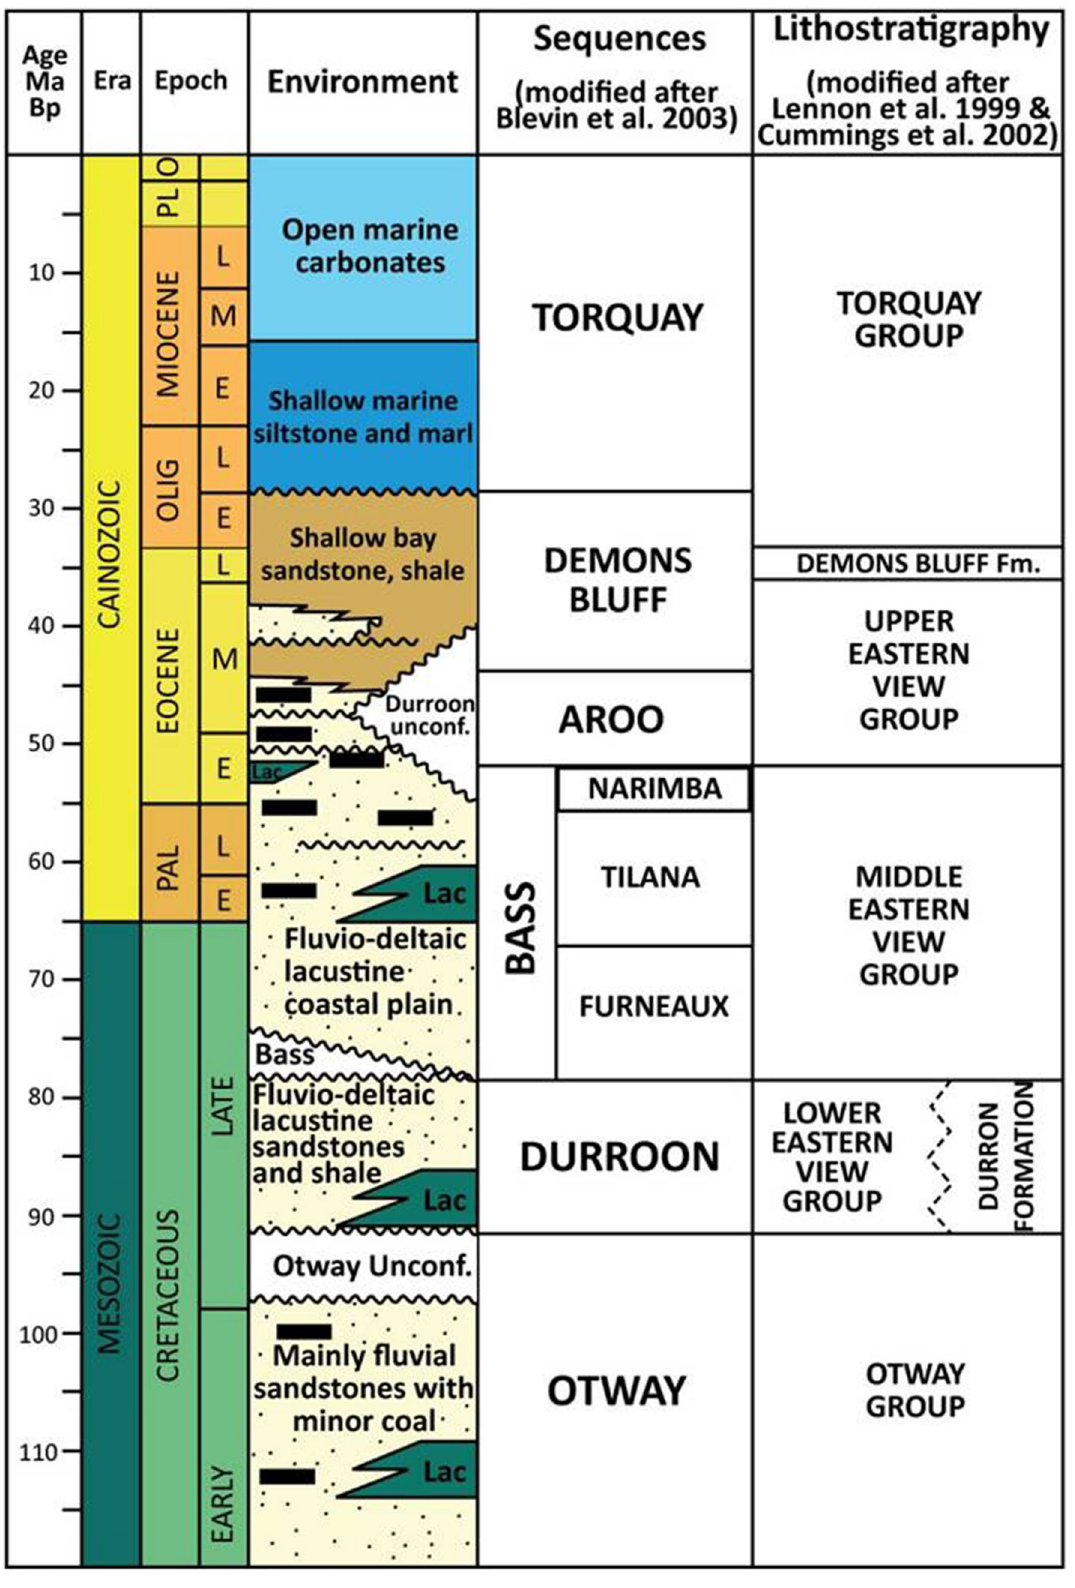
Fig. 3 Lithostratigraphic column of Bass Basin, highlighting the Late Paleocene-Early Eocene Narimba Formation (modified after Cummings et al.